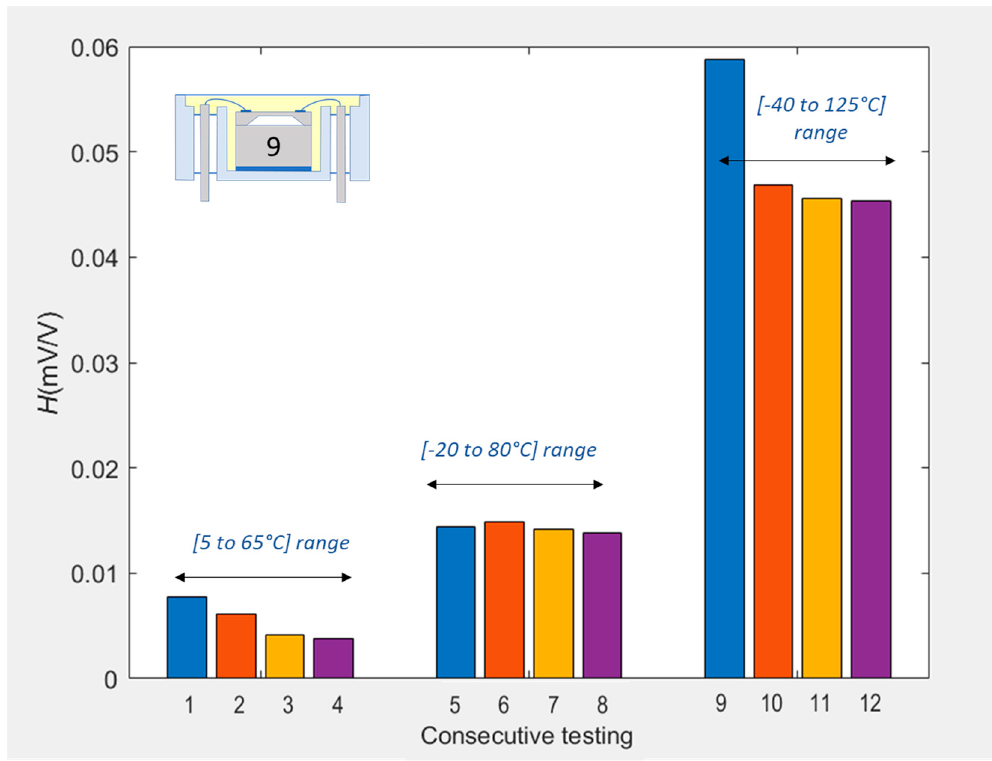
Figure 10. Hysteresis errors per cycle for the L2 packaged sensing element #9 sequentially subjected to the three temperature ranges. For each thermal range, the same colour of bar has been used for the same cycle number.